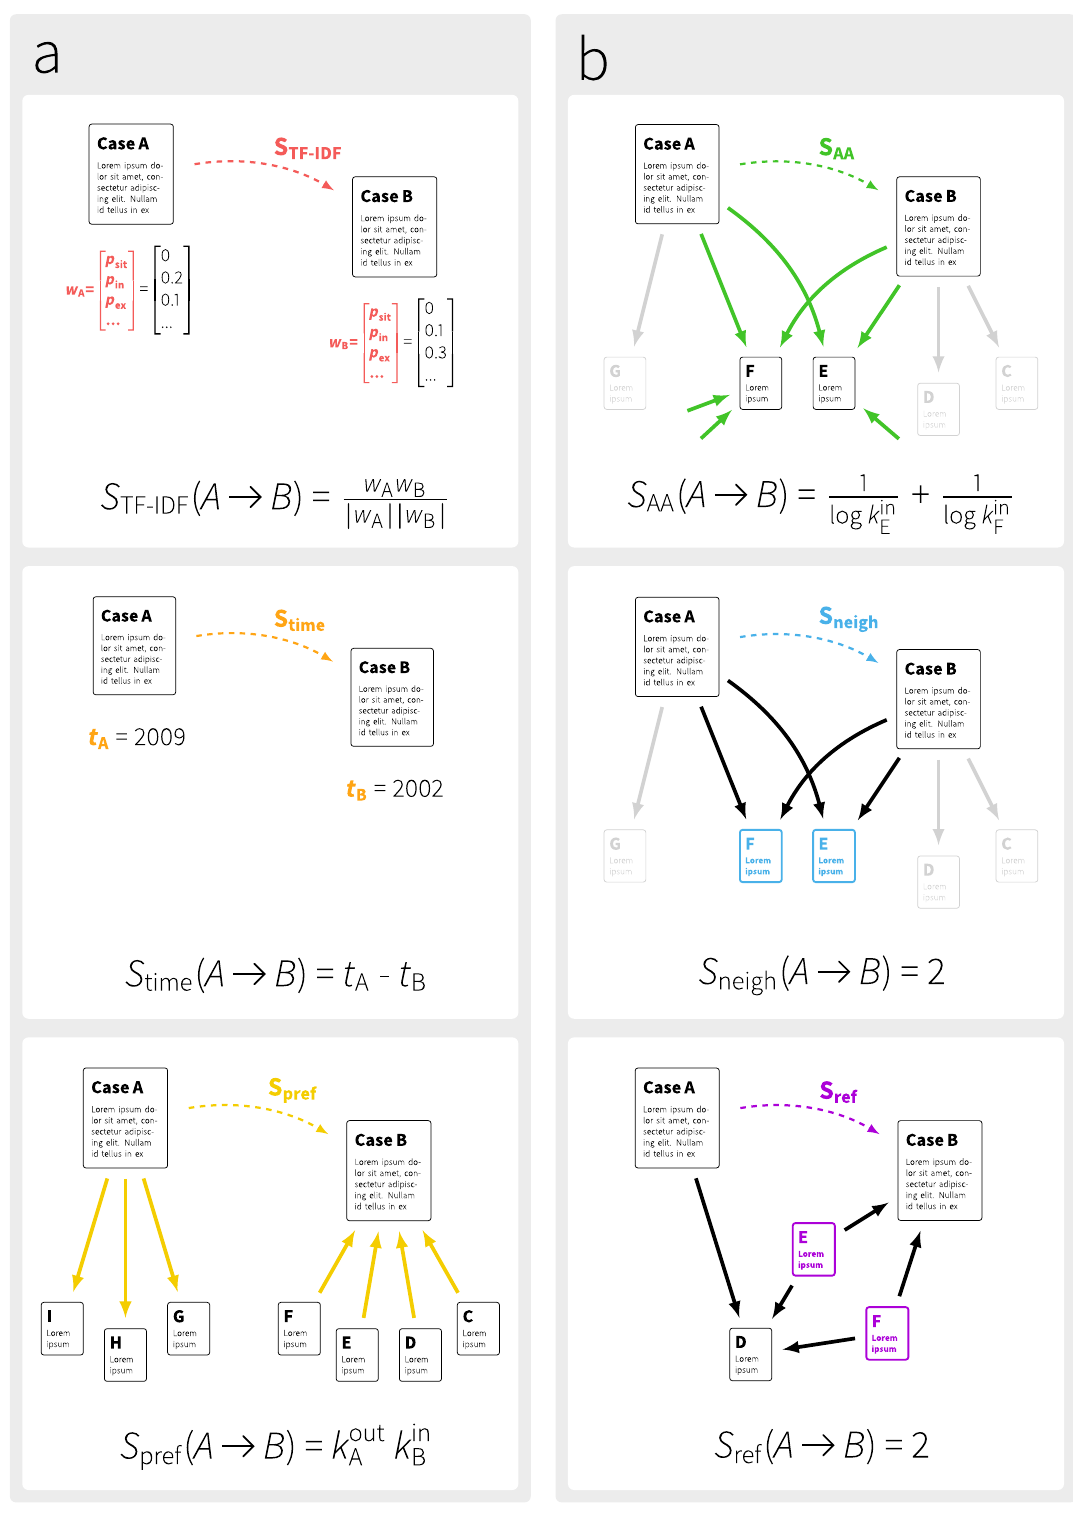
Figure 1. Features used in the inspection of the CJEU court. ( a ) Nodal features: TF-IDF ( S TF − IDF ) reflects similarity of content, time difference ( S time ) identifies how contemporary the two cases are; and preferential attachment ( S pref ) quantifies how many other cases refer to a candidate case. ( b ) Structural features: Adamic- Adar ( S AA ), common neighbors ( S neigh ), common referrers ( S ref ), all of which are inspired by features used in recommender systems and quantify the similarity between network “neighborhoods” of the